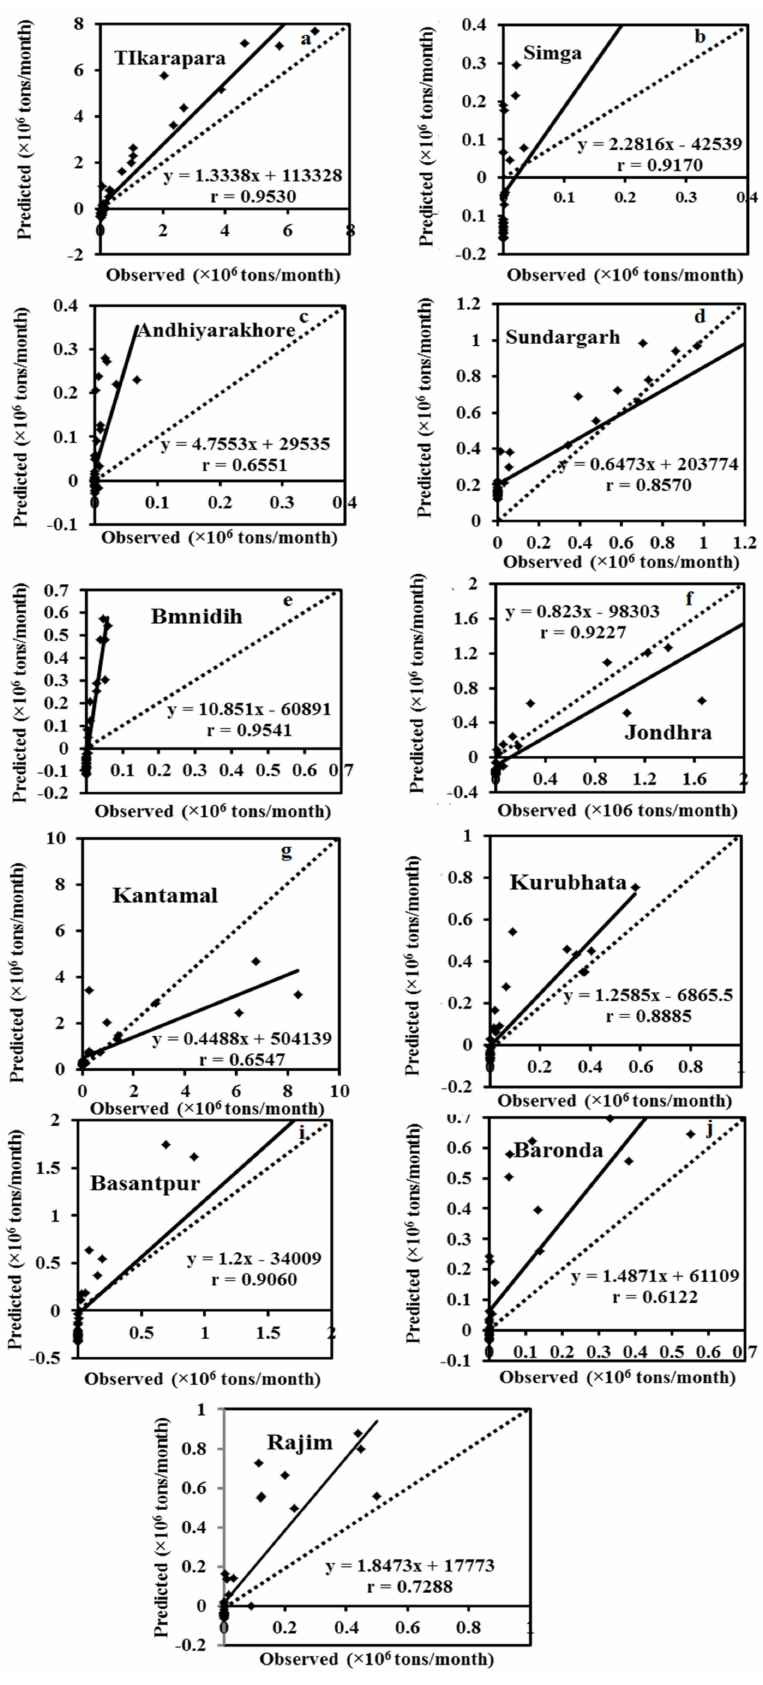
Figure 11. Scatter plots between predicted and actual SSY of testing data of the MLR